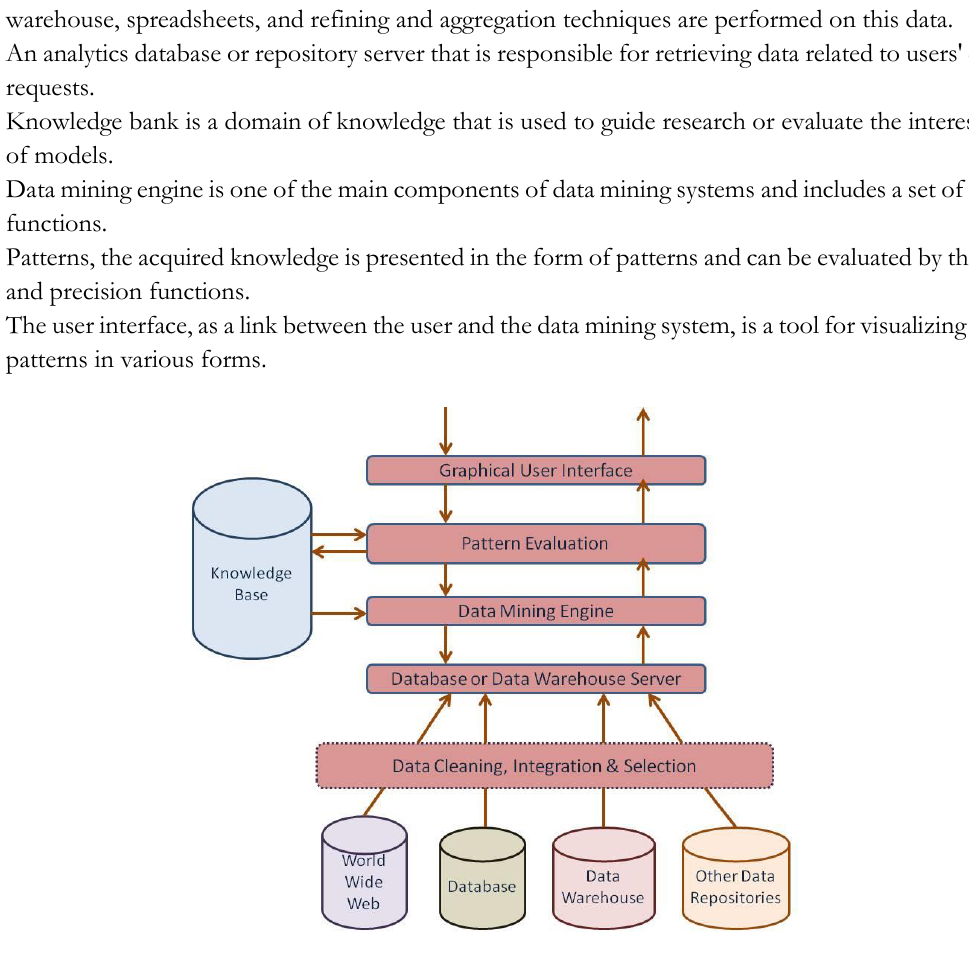
Fig. 1. Structure of data mining system.